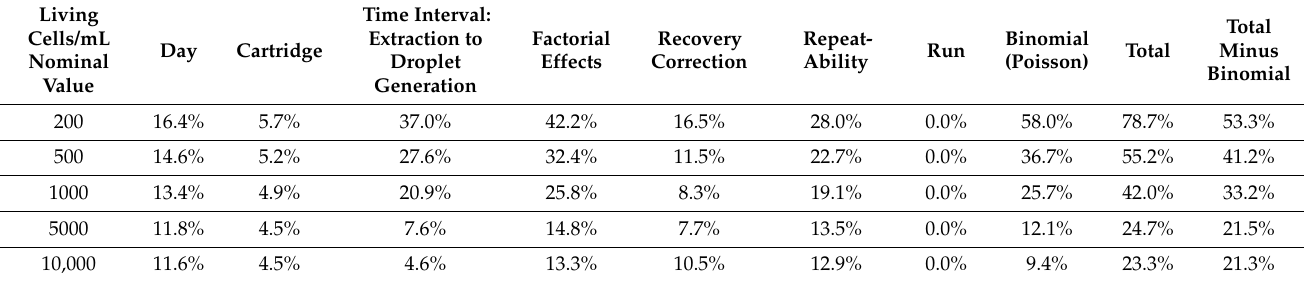
Table 9. Calculated RSD value for the technical uncertainty components—Supermix without dUTP.